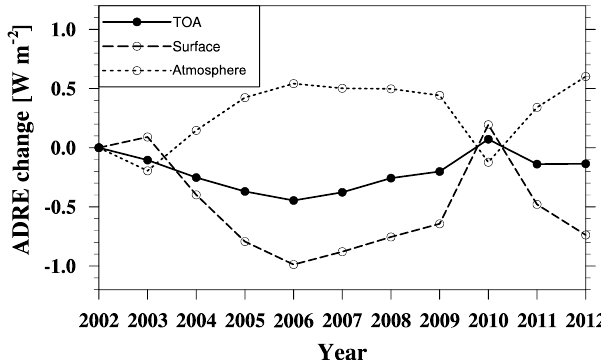
Figure 16. The change of ADREs at TOA, at the surface, and in the atmosphere relative to year 2002 due to the emission change from 2002 to 2012 in eastern China estimated by the MEIC development